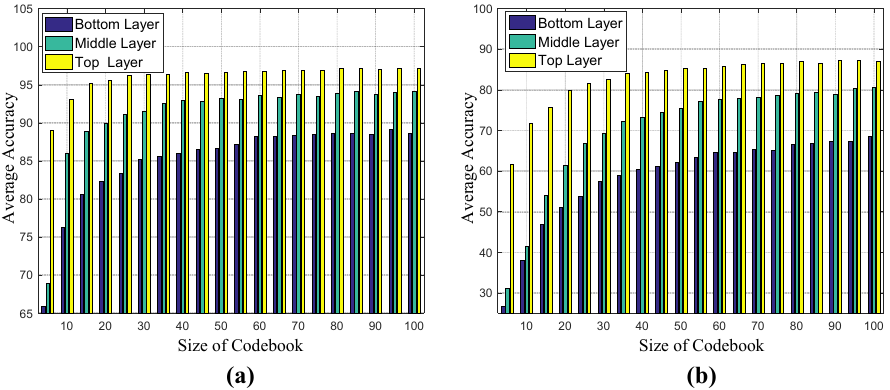
Figure 6. Average correct recognition rates as a function of the size of vector quantization (VQ) codebook for the three-layer sensing networks. ( a ) LOS scenario; ( b ) NLOS scenario.